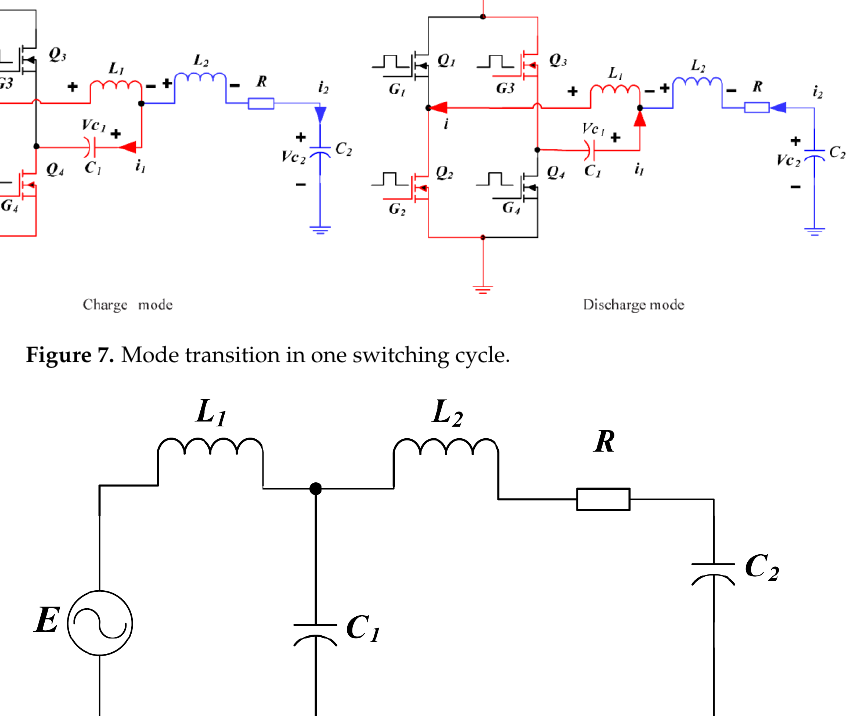
Figure 8. Resonant network of the converter in Figure 7.